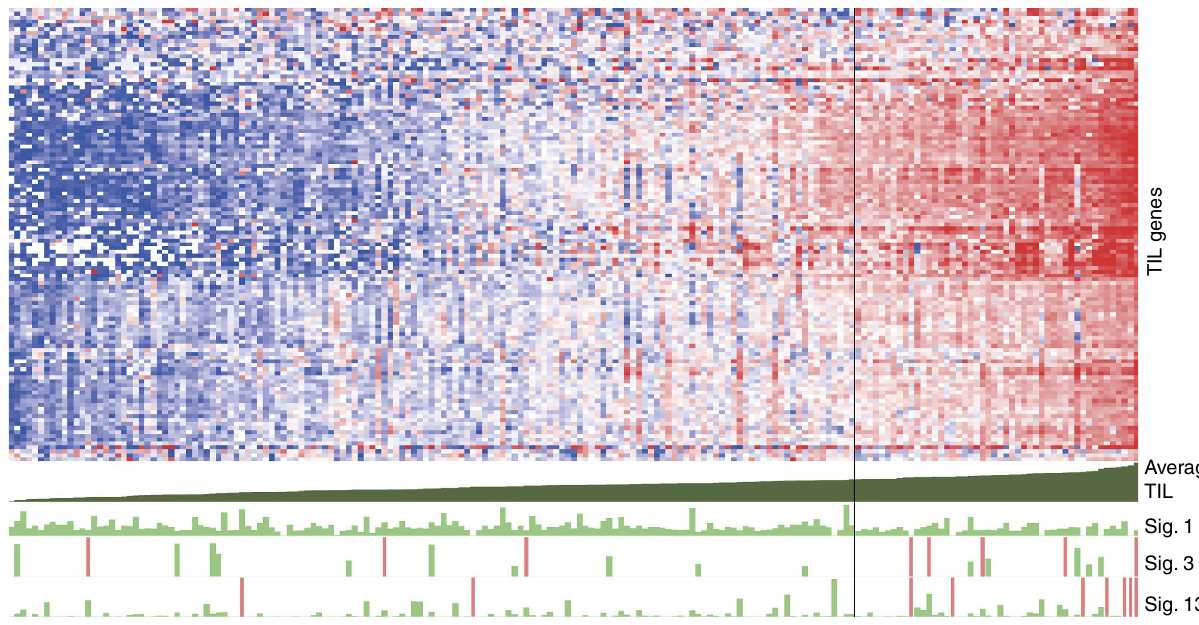
Figure 4 | Activity of TIL-signature genes related to mutational signatures. The average expression of genes ( n ¼ 116) from a TIL specific RNA-signature was used to rank ER-positive samples. The vertical black line indicates the third quartile border. Top panel: heatmap of median centred expression values in log2-FPKM, red indicates above median, blue below median expression. Genes are in rows, samples in columns. Below the heatmap: the first row shows the average expression of the TIL genes. Last three rows: the length of the green bar is proportional to the number of substitutions of the indicated signatures. Samples with 4 3,000 substitutions are shown with a soft-red coloured bar and are of equal length.